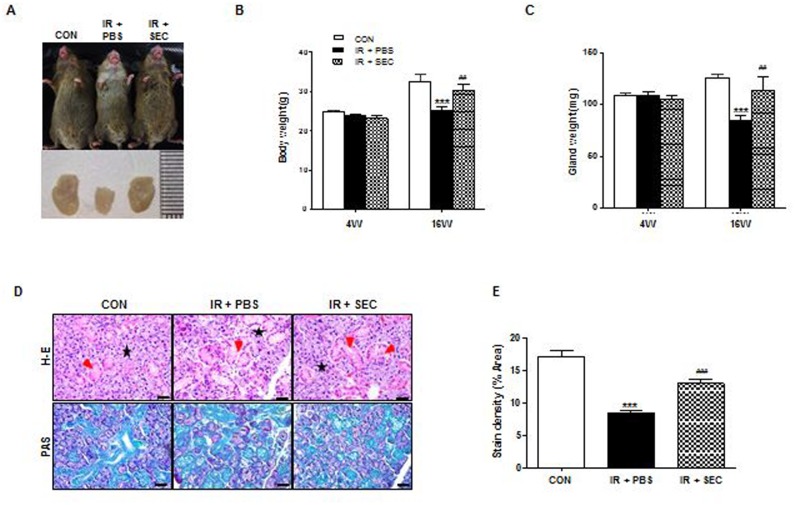
Macro- and micro-morphological evaluation.(A) External appearance and dissected SGs of mice in each group were photographed at 16 weeks after IR. (B and C) Body weight and dissected glandular weight were measured at 4 and 16 weeks after IR. (D) Representative histological pictures of H-E staining (upper) and PAS staining (lower) from three groups at 16 weeks post-IR are presented. Red arrows indicate ductal structures and stars mark acinar structures. Scale bars represent 50 μm. (E) Densities upon PAS staining were measured using a software program to calculate pixels of purple stained mucin-containing areas. Data are presented as the mean ± SEM. Two-way ANOVA, Bonferroni post hoc test (B and C), One-way ANOVA, Tukey’s pot hoc test (E). *, compared to CON; #, compared to IR + PBS. ***P <0.001, ##P < 0.01, and ###P < 0.001. CON, normal control group (n = 6–7); IR + PBS, PBS-treated group (n = 6); IR + SEC, secretome-treated group (n = 6).